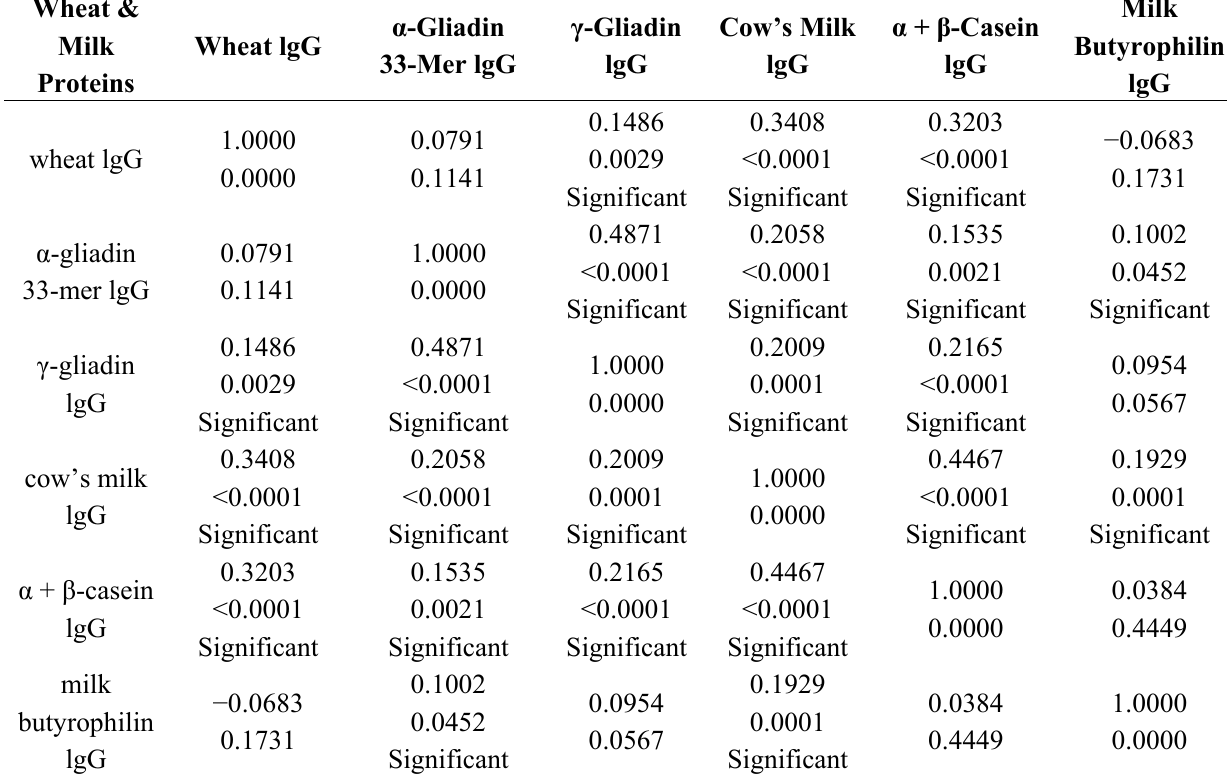
Table 4. Results of the simple linear regression between each pair of lgG isotype of the antigens. The first number in each cell presents corresponding Pearson’s correlation coefficient and the second number presents its p -value. Small p -value (less than 0.05) indicates statistical significance. Note that R 2 values of these regressions are the squares of the Pearson’s correlation